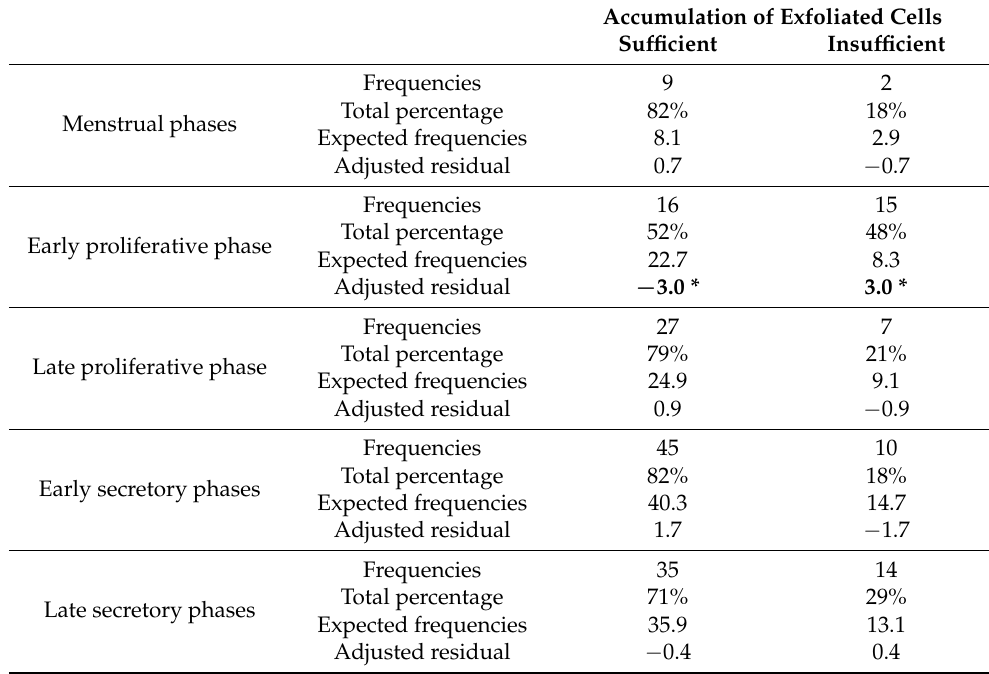
Table 2. Cross-tabulation of the menstrual cycle phases and the accumulation of exfoliated cells.